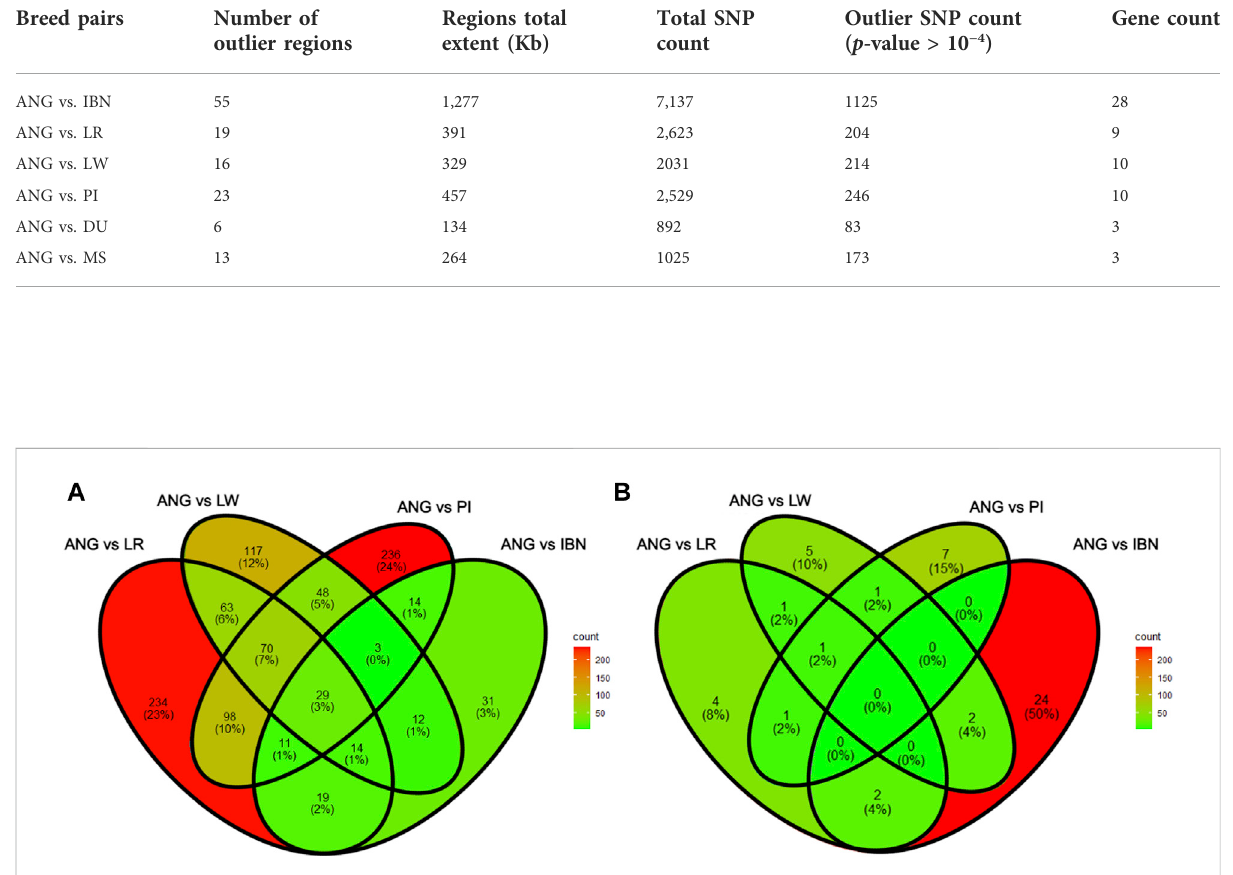
FIGURE 8 Venndiagramsofsharedgenesidenti fi edwhencomparingANGwithEuropeandomesticpigswithxp FST / θ π andxpEHHanalyses. (A) Numberof shared candidate genes between the four pairwise comparisons obtained using xp FST / θ π . ( B) Number of shared candidate genes between the four pairwise comparisons obtained using xpEHH.